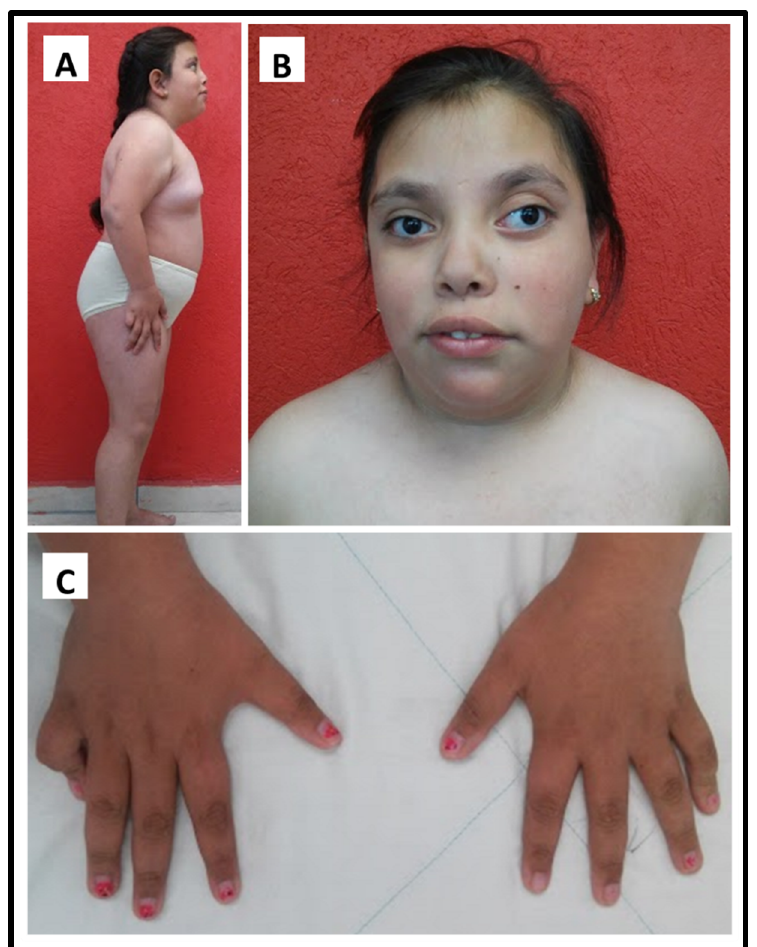
Figure 1. The phenotype of the proband: ( A ) Habitus: short stature, obesity, short neck, rhizomelic shortening of the limbs, hyperlordosis, and limited extension of the elbow. ( B ) Facies: mild frontal bossing, broad nasal bridge, anteverted nostrils, severe nystagmus, divergent left ‐ eye strabismus, low ‐ set ears, short nasal columella, full lips. ( C ) Bilateral fifth finger camptodactyly.